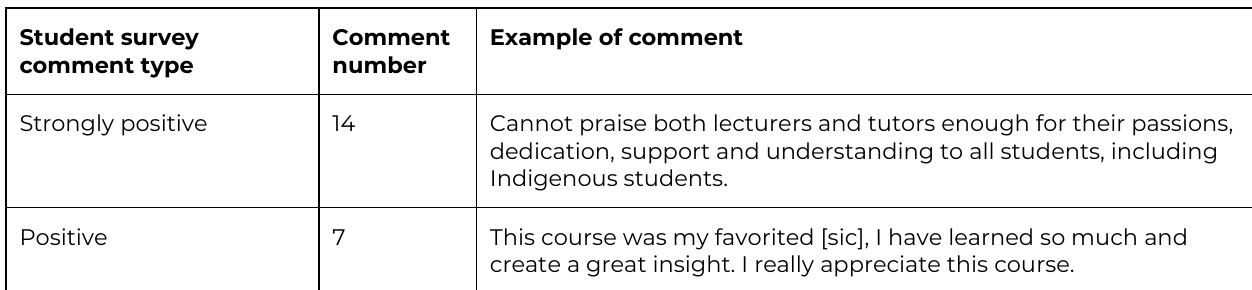
Table 5: Overview of comments Semester 2 2019 Student